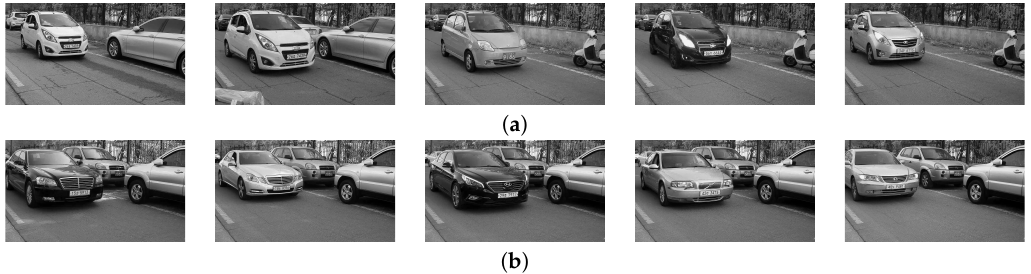
Figure 1. ( a ) Subcompact vehicles and ( b ) sedans. It is not easy to differentiate two classes using small features such as head lamp or rear-view mirror. On the other hand, there are differences in bigger features such as bonnet and overall shape of